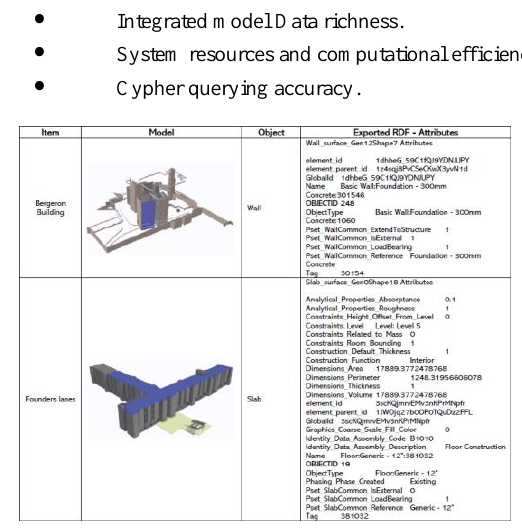
Table 1: RDF exported attributes from BIM-GIS Semantic